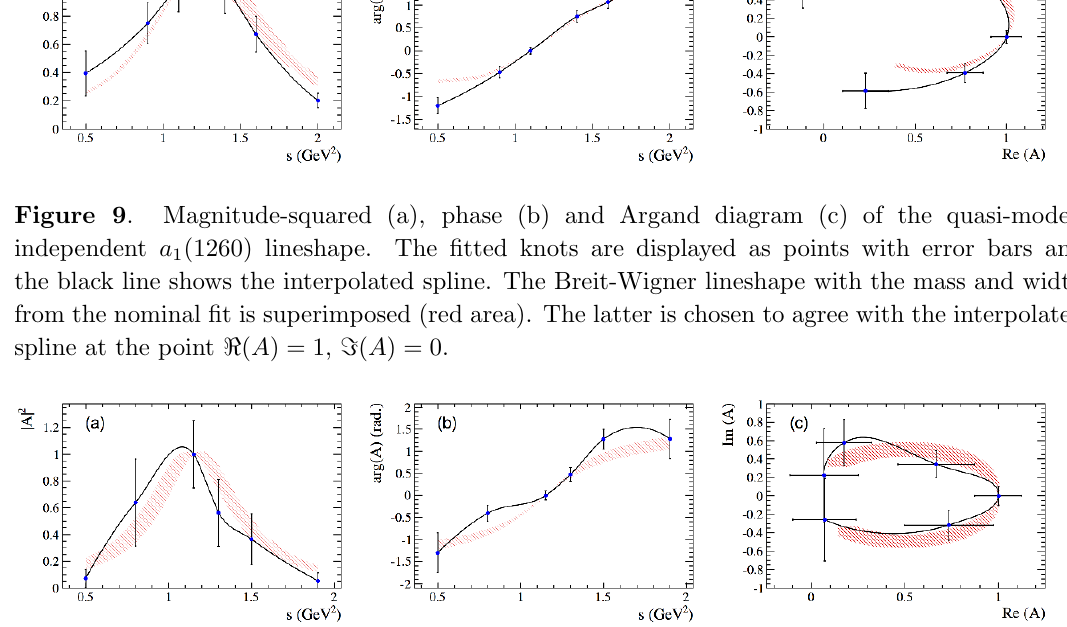
Figure 10 . Magnitude-squared (a), phase (b) and Argand diagram (c) of the quasi-model- independent (cid:25) (1300) lineshape. The (cid:12)tted knots are displayed as points with error bars and the black line shows the interpolated spline. The Breit-Wigner lineshape with the mass and width from the nominal (cid:12)t is superimposed (red area). The latter is chosen to agree with the interpolated spline at the point < ( A ) = 1, = ( A ) =